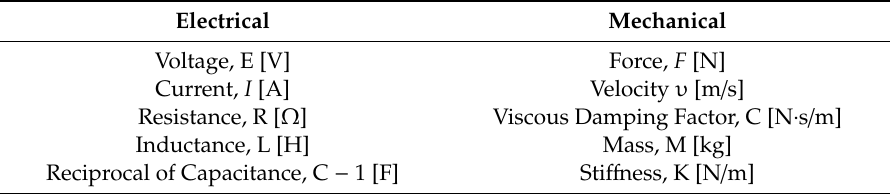
Table 1. Correspondence relationship between a mechanical and electrical